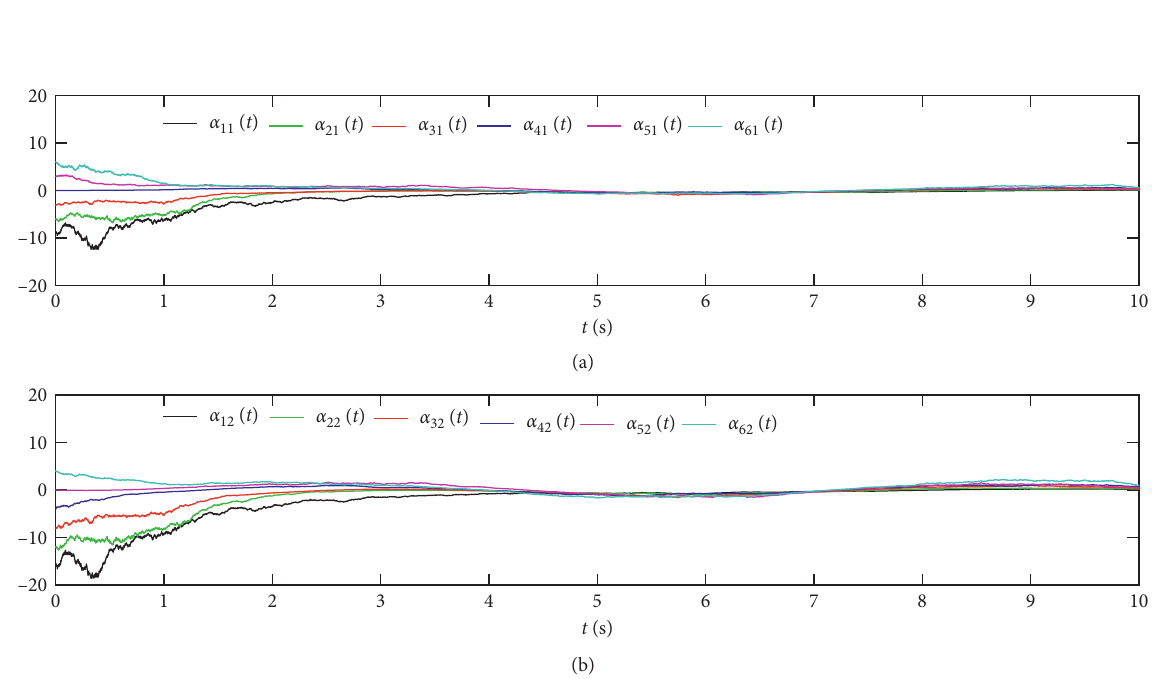
( t ) , α ( t ) , and α z 1 z 2